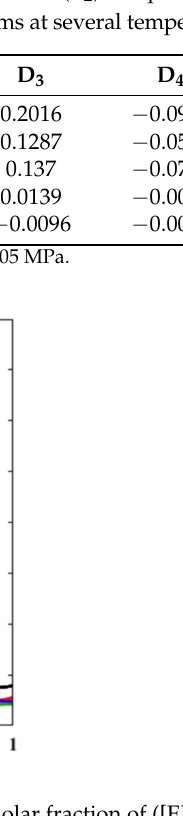
Table 8. The fitting parameters (D i ) and the determination coefficients (R 2 ) of Equation (6) for absorption